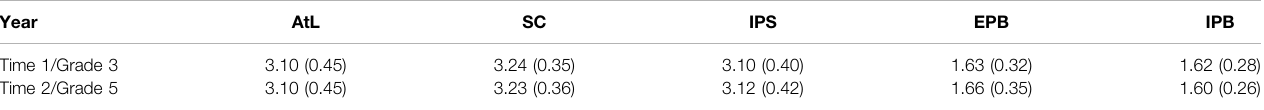
TABLE 1 | Summary of observed